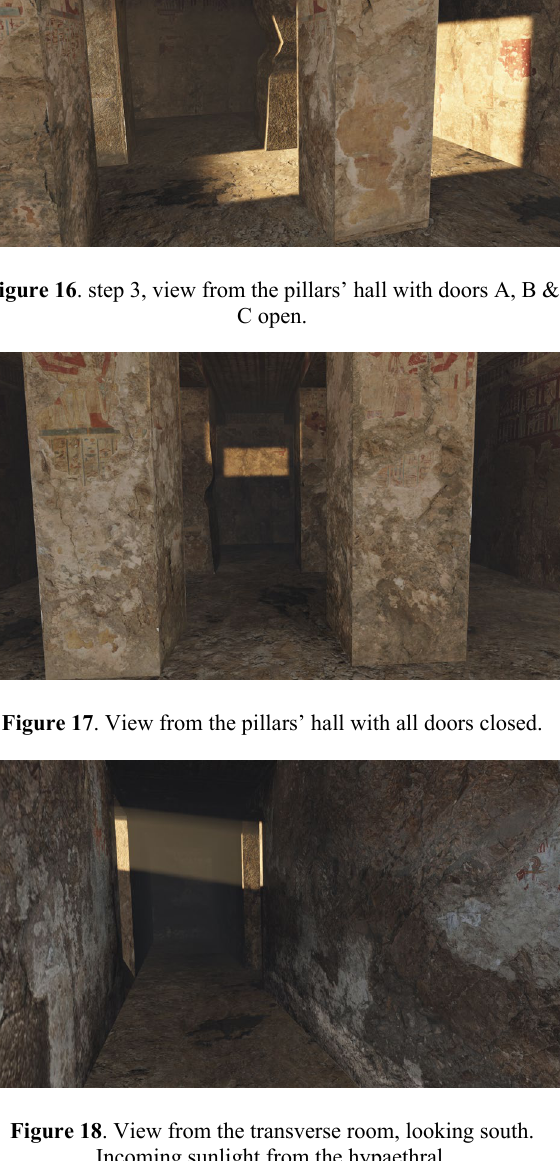
Figure 18 . View from the transverse room, looking south. Incoming sunlight from the